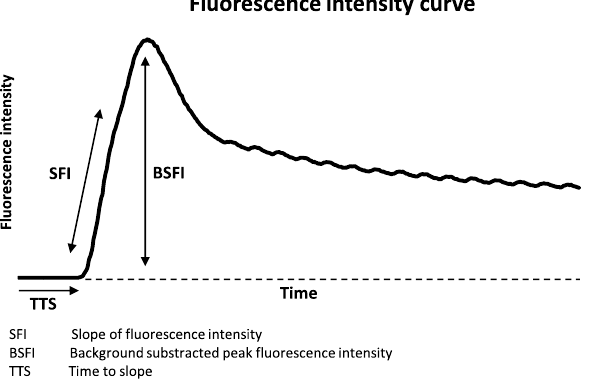
Figure 3. Figure shows a time-dependent fluorescence intensity curve and a schematic presentation for calculating the quantification parameters SFI, BSFI, and TTS. TTS defines the time between Indocyanine green (ICG) administration and the first fluorescence signal. SFI represents the maximal slope of the curve. For the calculation of BSFI, the initial fluorescence intensity before injection of ICG is subtracted from the peak fluorescence